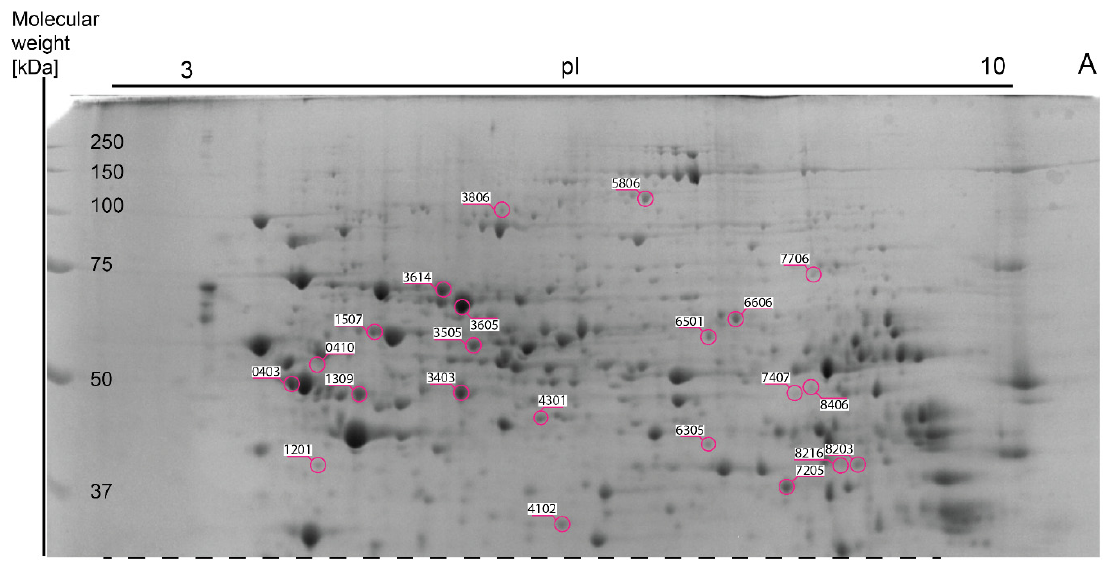
Figure 4. Part A of Figure 3 eresentative 2DE map of liver proteins stained with Coomassie Brilliant Blue G-250). Spot numbers (SSP) and areas of differential spots in the figure correspond to the SSP number in Table 3.